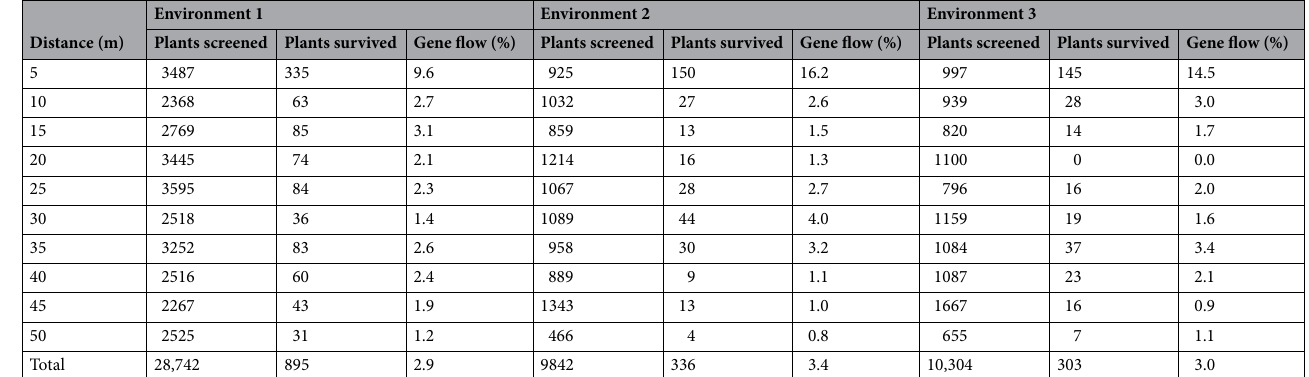
Table 1. Frequency of pollen-mediated gene flow in johnsongrass for distances up to 50 m from the pollen source in three environments. Johnsongrass seed collection time: Environment 1, July 2018; Environment 2, November 2018; and Environment 3, September 2019.